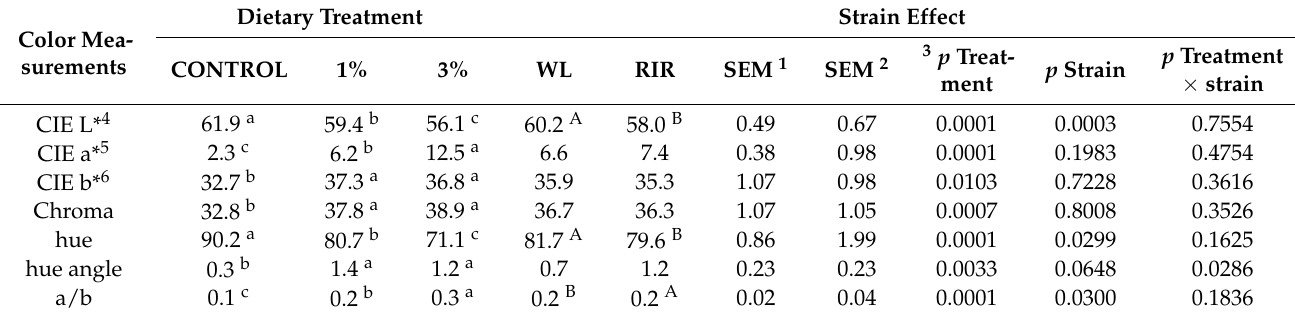
Table 4. Effect of dietary spirulina and strain of laying hens (White Leghorn: WL or Rhode Island Red: RIR) on color of yolk. Color